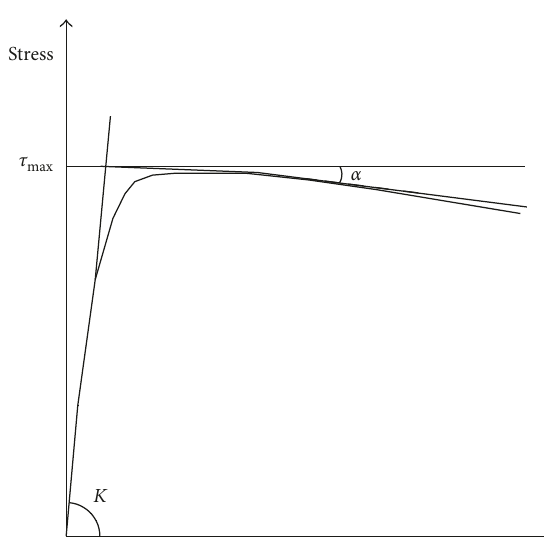
Figure 10: Typical traction-separation behavior adopted in the simulations.